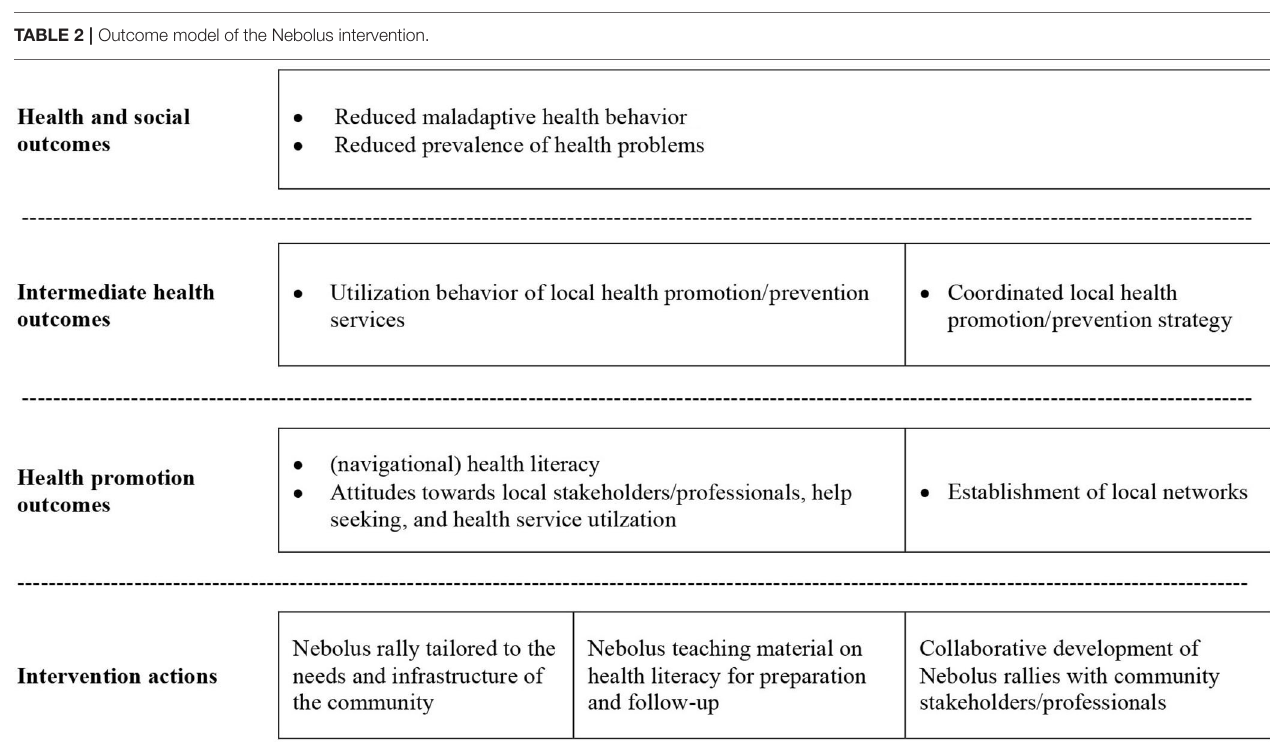
outcome assumptions based on the available evidence. As depicted in Table 2 , we assume that Nebolus rallies and the accompanying teaching material lead to direct health promotion outcomes, which are improvements in (navigation)